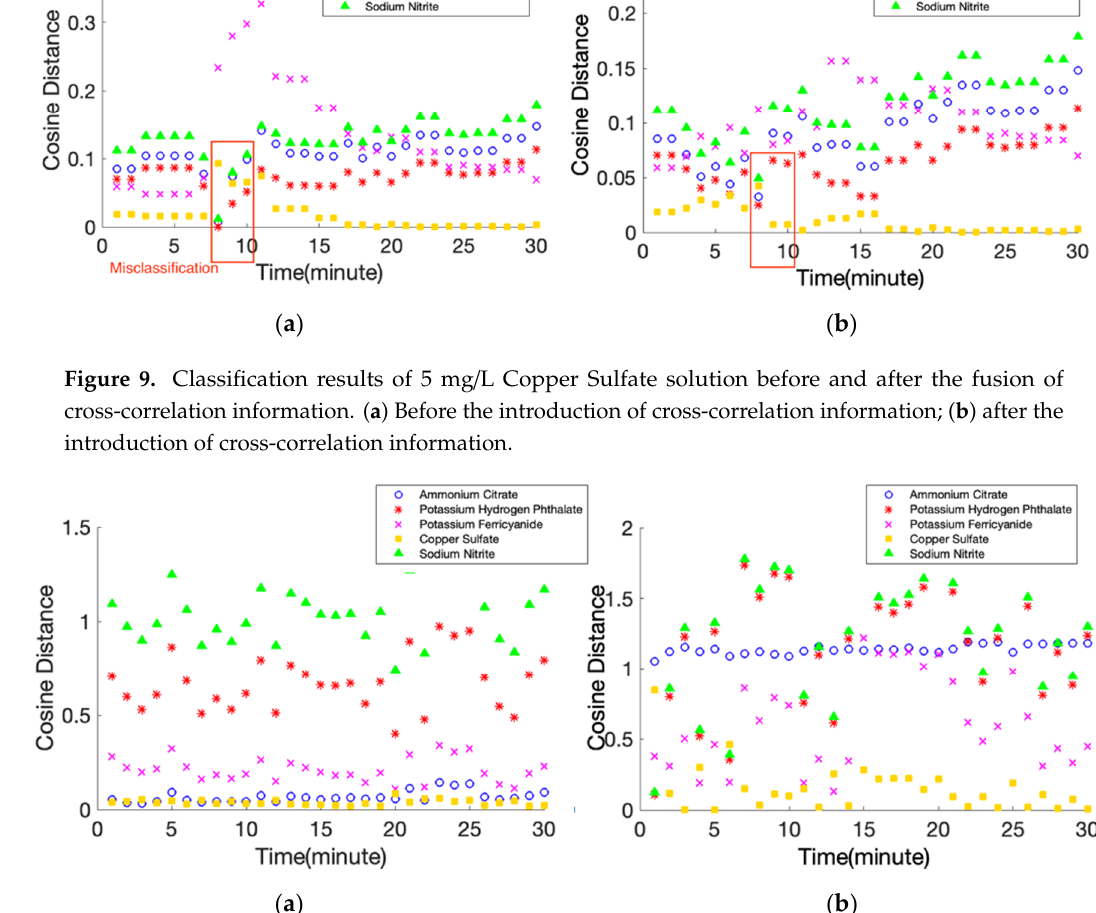
Figure 9. Classification results of 5 mg/L Copper Sulfate solution before and after the fusion of cross- correlation information. ( a ) Before the introduction of cross-correlation information; ( b ) after the introduction of cross-correlation information.